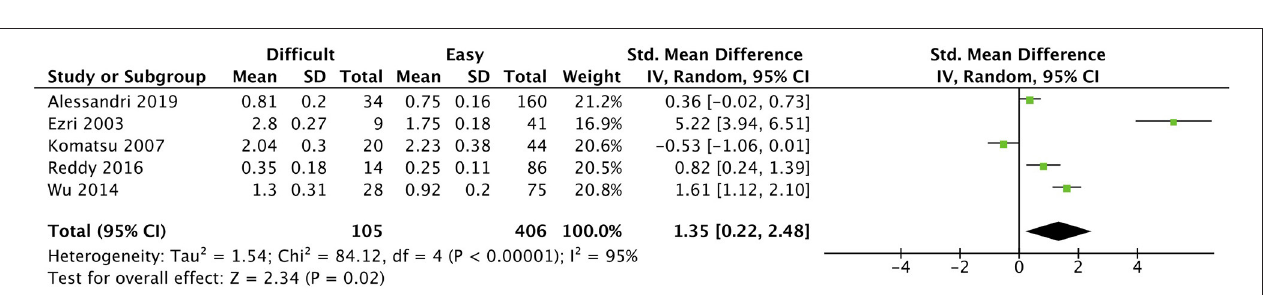
FIGURE 3 | Skin to Epiglottis distance at THM level forest plot comparing difficult and easy laryngoscopy groups.